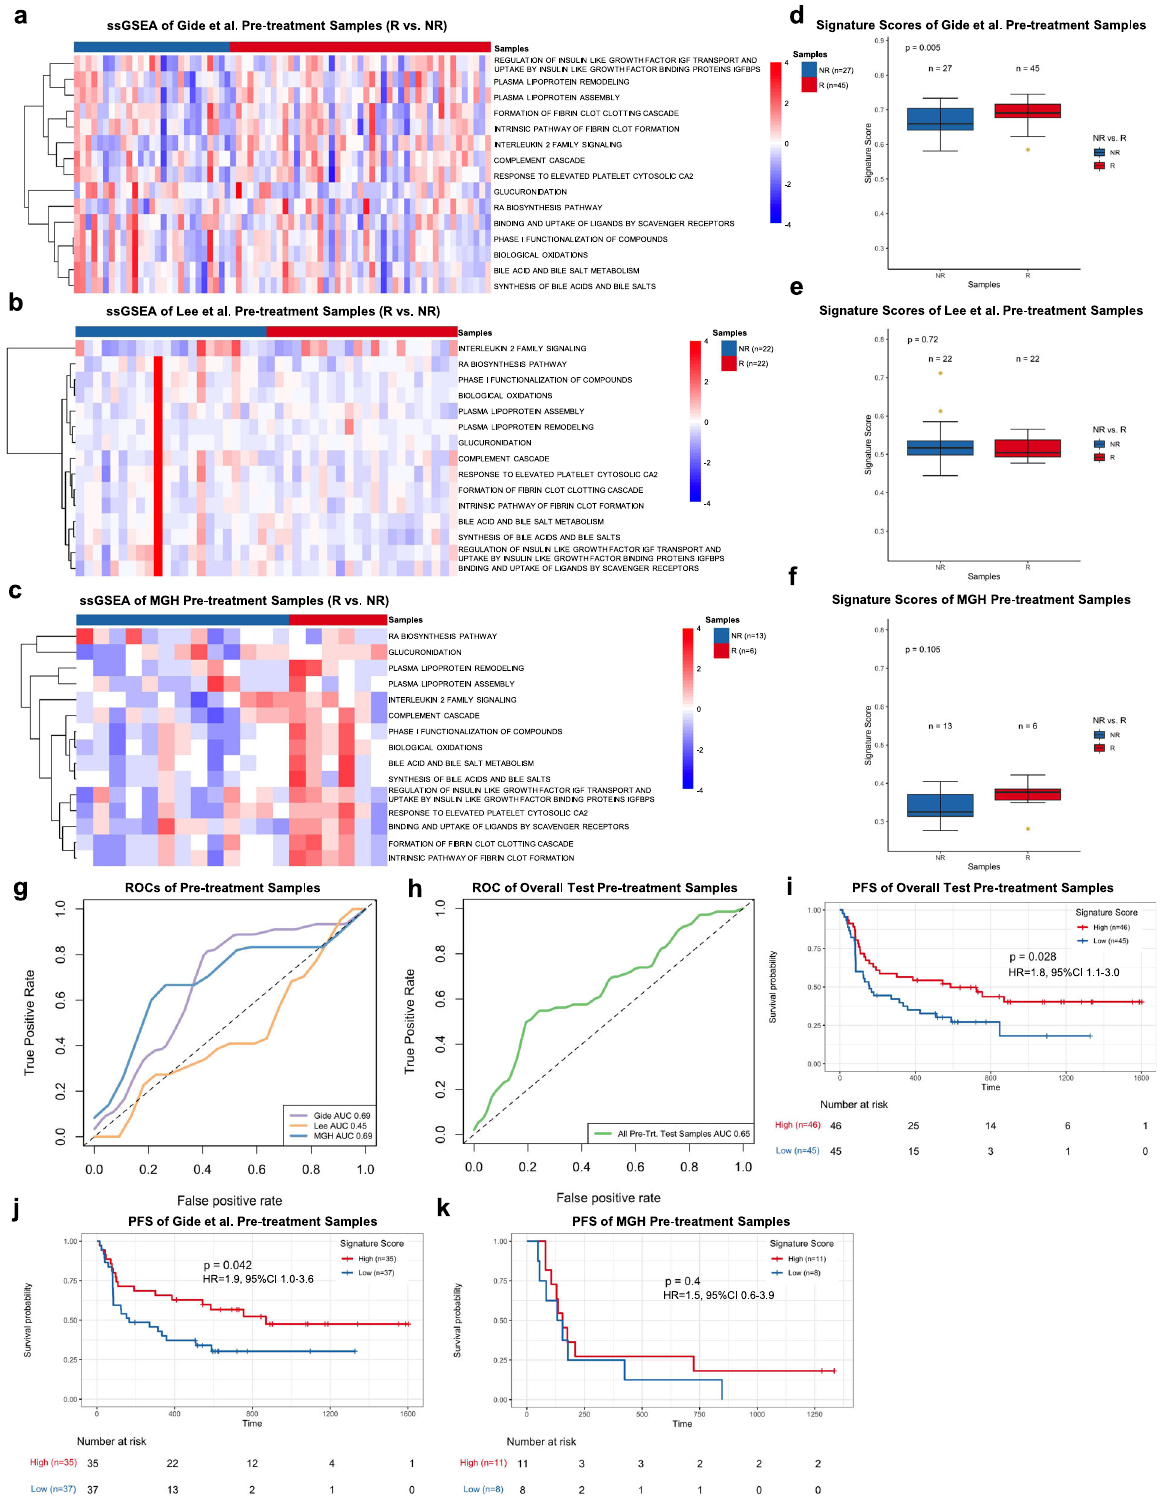
(Supplementary Fig. 1h). For the MGH cohort, signi fi cantly improved OS (HR = 3.4, 95% CI 1.0 – 12.0, p = 0.04) but not PFS (HR = 1.5, 95% CI 1.1 – 3.9, p = 0.4) was observed in patients with high signature scores compared to those with low scores (Fig. 3k and Supplementary Fig.